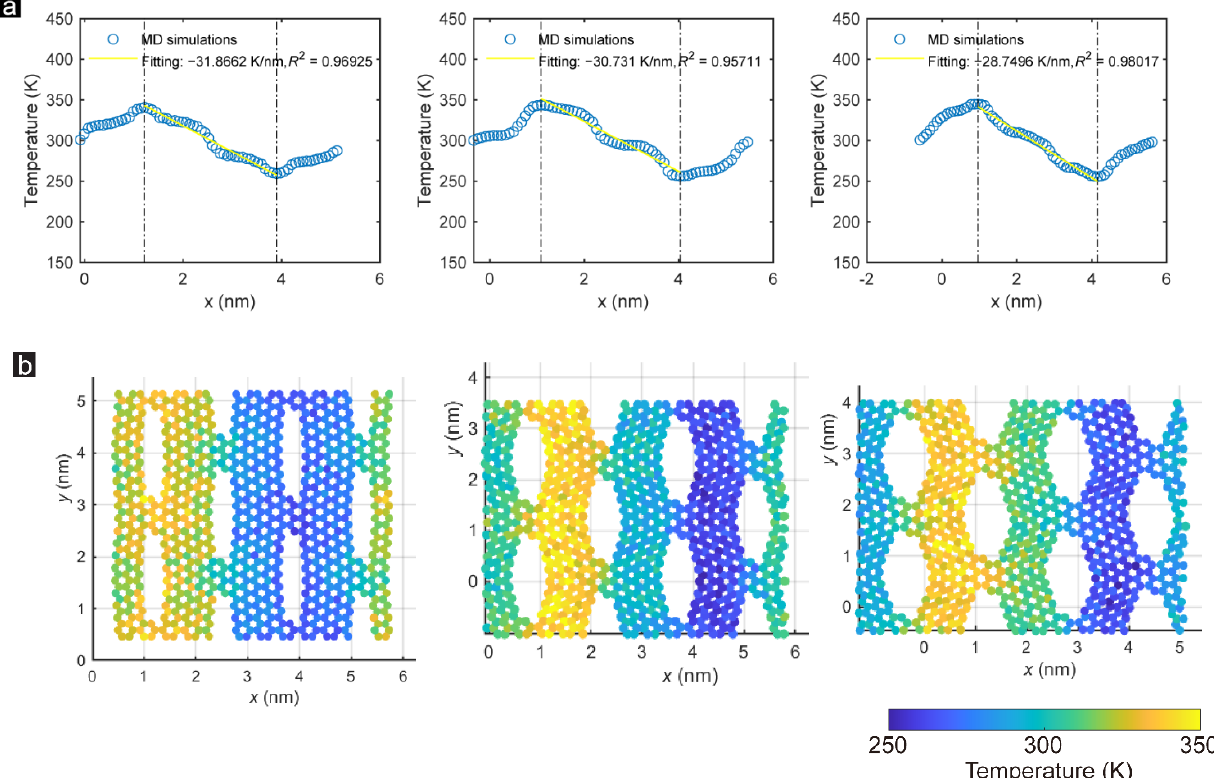
Figure 7. ( a ) Time-averaged temperature distribution of each atom along the direction perpendicular to the zigzag-incised GK incisions under 5%, 15%, and 25% strain. ( b ) Snapshots of the temperature distribution of Samples ZZ_1_1_5%, ZZ_1_1_15%, and ZZ_1_1_25% after one nanosecond of heat conduction.